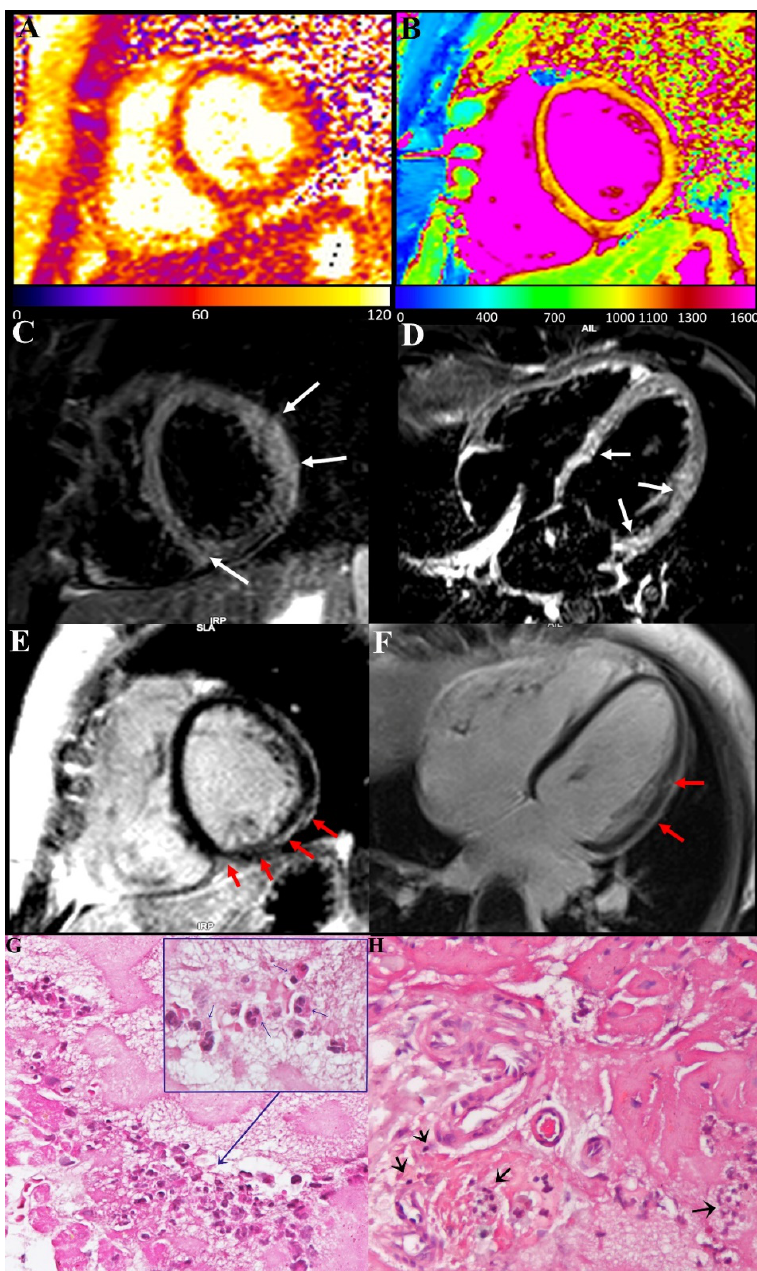
Figure 2. Eosinophilic myocarditis with conduction tissue involvement after COVID-19 mRNA vaccination. ( A , B ): Myocardial T2 (A) and T1 (B) maps, acquired on mid-ventricular short-axis view, showed a diffuse increase in both T2 and T1 myocardial value as a result of a diffuse inflammatory involvement. ( C , D ): Presence of myocardial edema was also confirmed on STIR T2-weighted images acquired on short-axis (C) and horizontal long-axis (D) views as multiple areas of hyperintense signal within the basal septum, the inferior interventricular junction and mid-basal anterolateral wall (arrows). ( E , F ): Late-enhancement images acquired on the same short-axis (E) and horizontal long-axis (F) planes reveal tiny areas of mild enhancement with “patchy” distribution and predominant involvement of subepicardial layer in the same location of the above-mentioned myocardial edema (red arrows). ( G , H ): Histology shows degranulation of crystalloids of eosinophilic granulocytes (see insert and blue arrow) responsible for the release of the cationic protein and ultimately for myocardial damage and a strongly infiltration of eosinophils in the conduction tissue (Panel H) (black arrow).( 400x magnification )